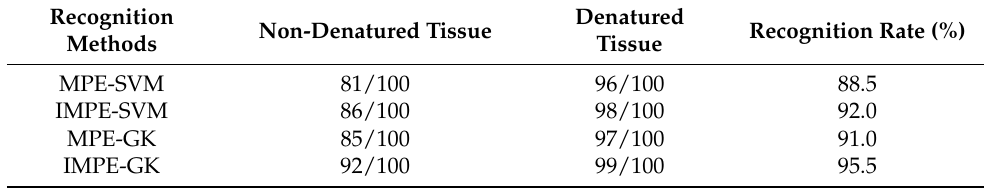
Table 2. Recognition results with different methods.